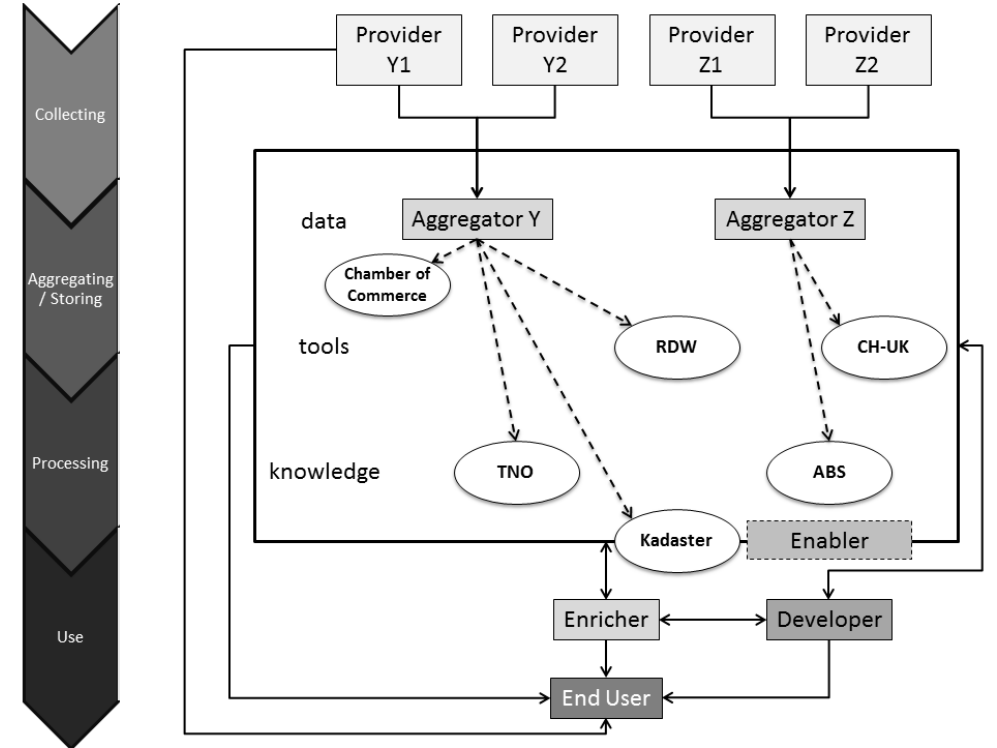
Figure 5: Shift in roles in the PSI chain for the researched agencies after introduction of open